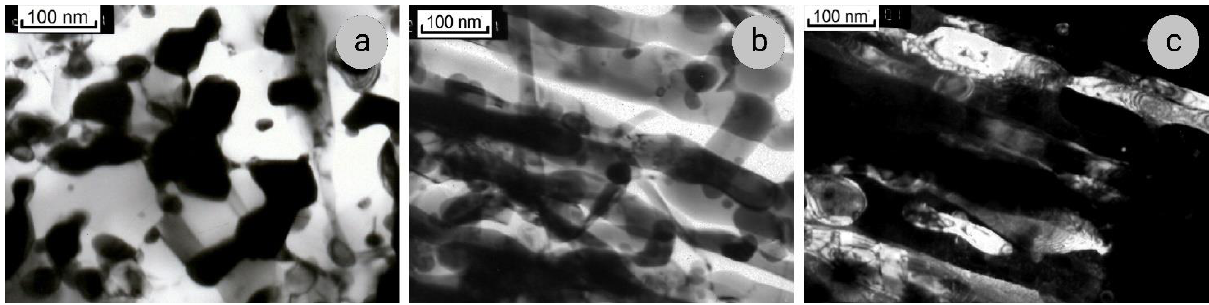
Figure 7. The structure of Sample 2 ( e = 12.5) in transverse sections after the annealing for 1 h at 300 ° С ( a ), 400 ° С ( b ), and 500 ° С ( c ).